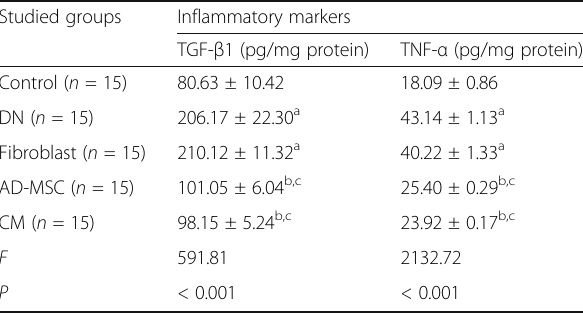
Table 4 TNF- α and TGF- β assessment in the different studied rats ’ groups Studied